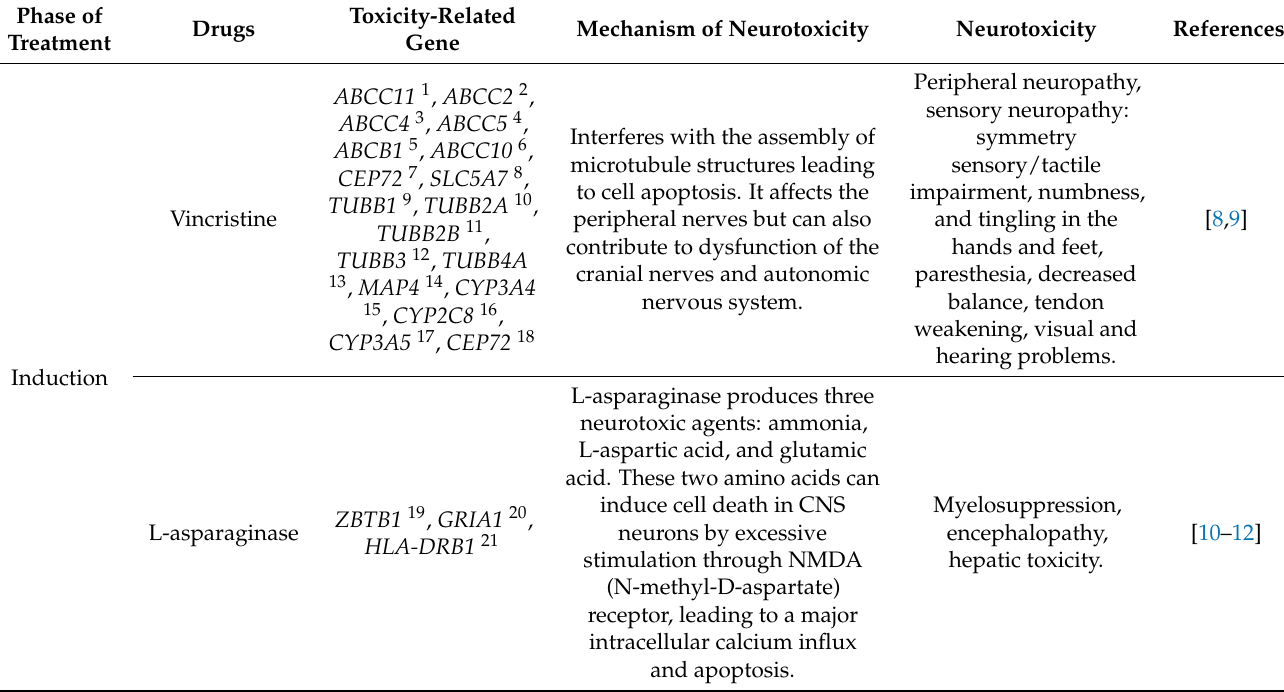
Table 1. Treatments used in ALL and associated neurotoxicity. Phase of